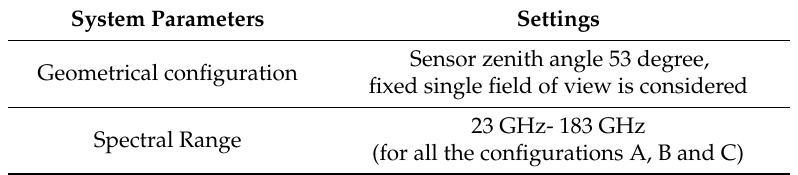
Table 1. End-to-End simulation settings for three MW instrument configurations set